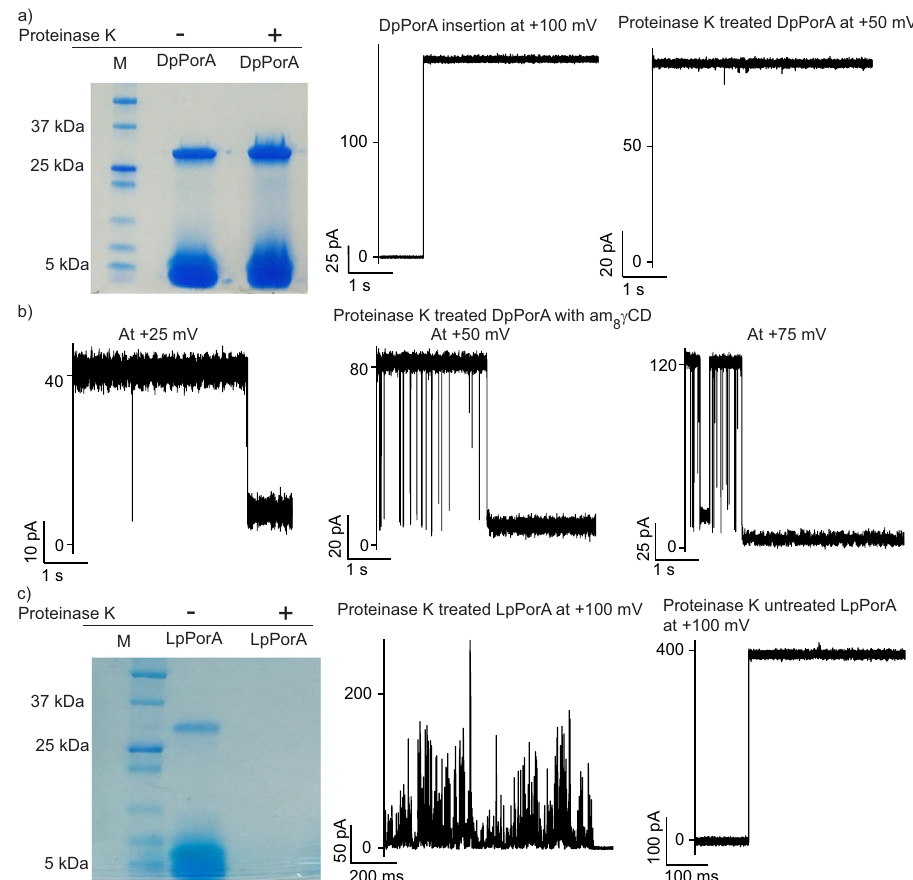
Fig. 3 | Functionalstability ofDpPorA toprotease reaction. a DpPorA peptides treated with proteinase K run on SDS-PAGE showing monomer and pre- oligomer band. Data are representative of more than three repeats. Single stable pore insertion of gel extracted proteinase K treated DpPorA peptides at +100mV and single DpPorA in stable conductance state at +50mV. b Interaction of proteinase K reacted DpPorA with am 8 γ CD (10 μ M, trans) at